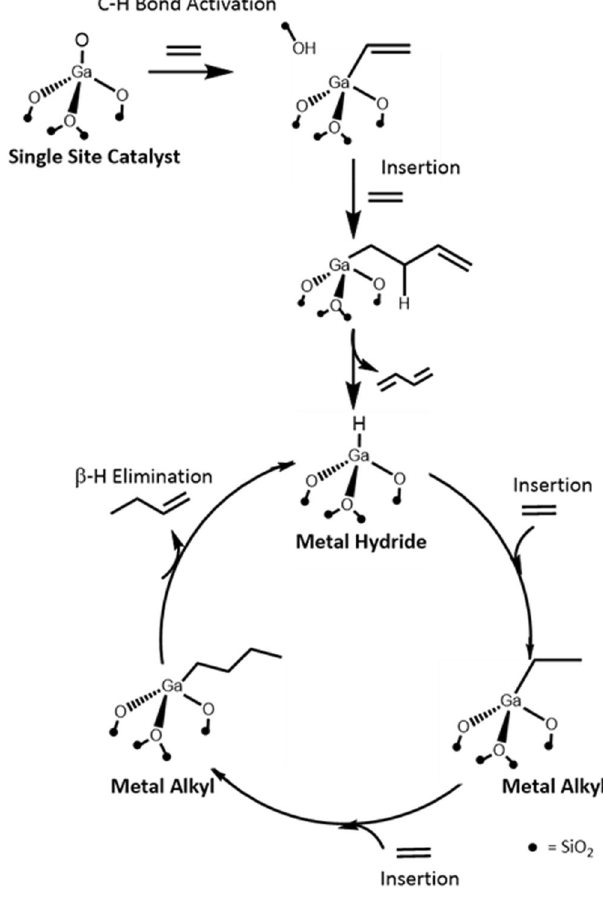
Fig. 5 Proposed oligomerization pathway for single site, Ga 3 + catalysts. Formation of the pre-catalyst to the fi rst Ga – H intermediate, elementary steps and reaction